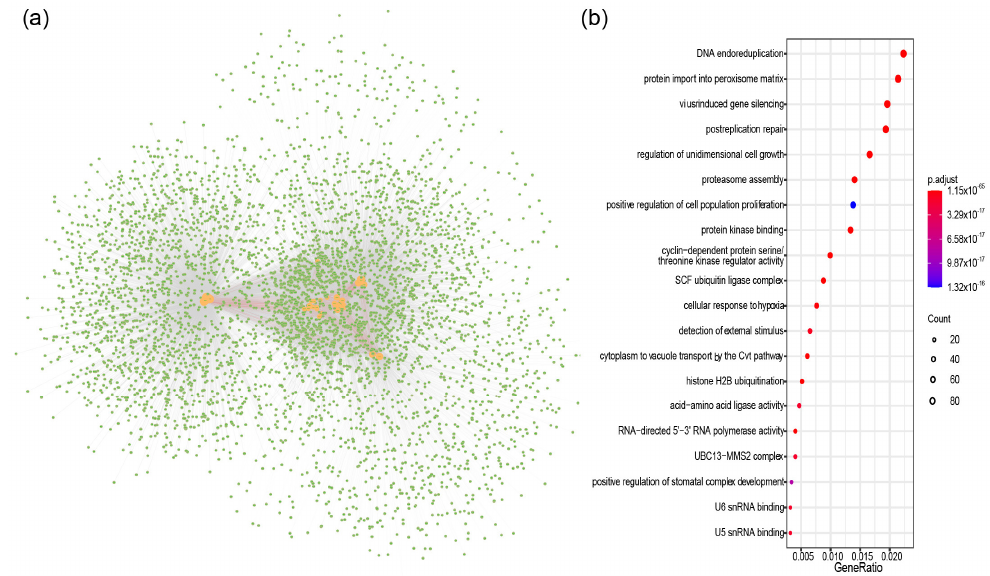
Figure 5. The ARI-protein interaction-network analysis in B. napus . ( a ) Protein–protein interaction network of BnARI proteins. The BnARI proteins are shown by orange circles, the green circles represent proteins that interacted with BnARI proteins. The red lines indicate the interaction between BnARI proteins, and the gray lines indicate the interaction between BnARI and other proteins. ( b ) KEGG pathway analysis of proteins interacted with BnARI proteins. The color bar shows the value of p .adjust from low (red) to high